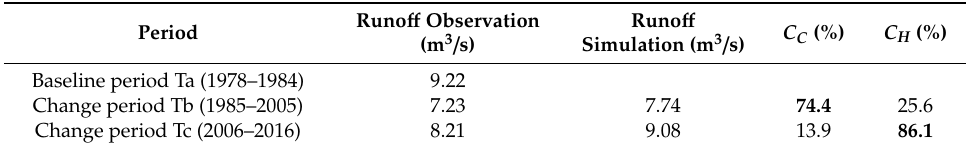
Table 8. Contribution rates of climate change and anthropogenic activities to runo ff variations using SWAT